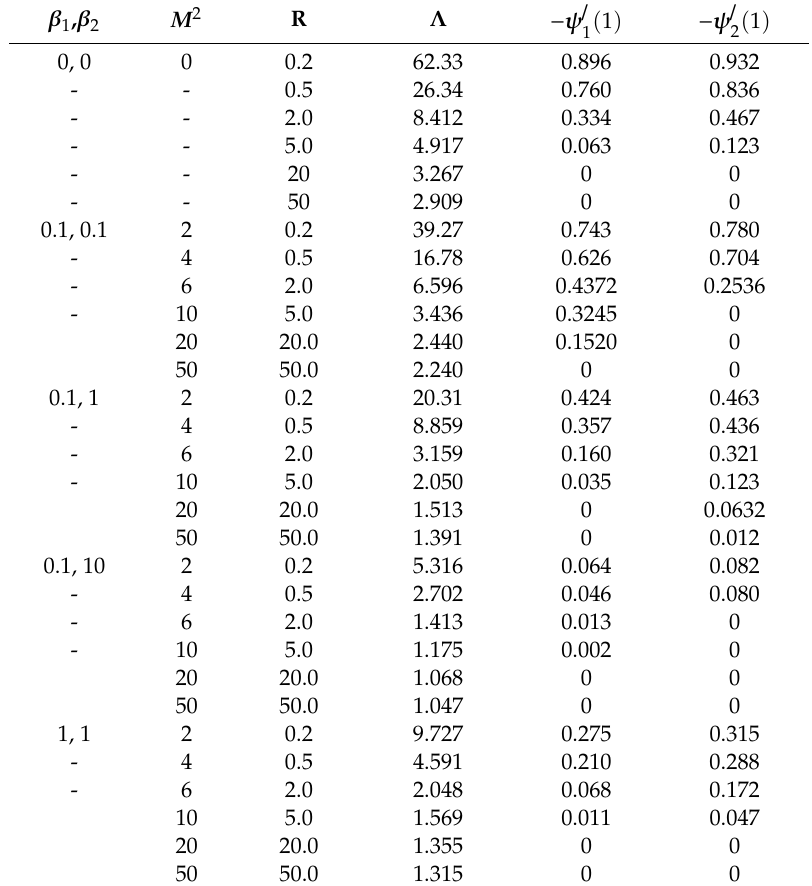
Table 1. Properties of the long porous slider. Normalized lift Λ , normalized x 1 − direction drag, and normalized x 2 − direction